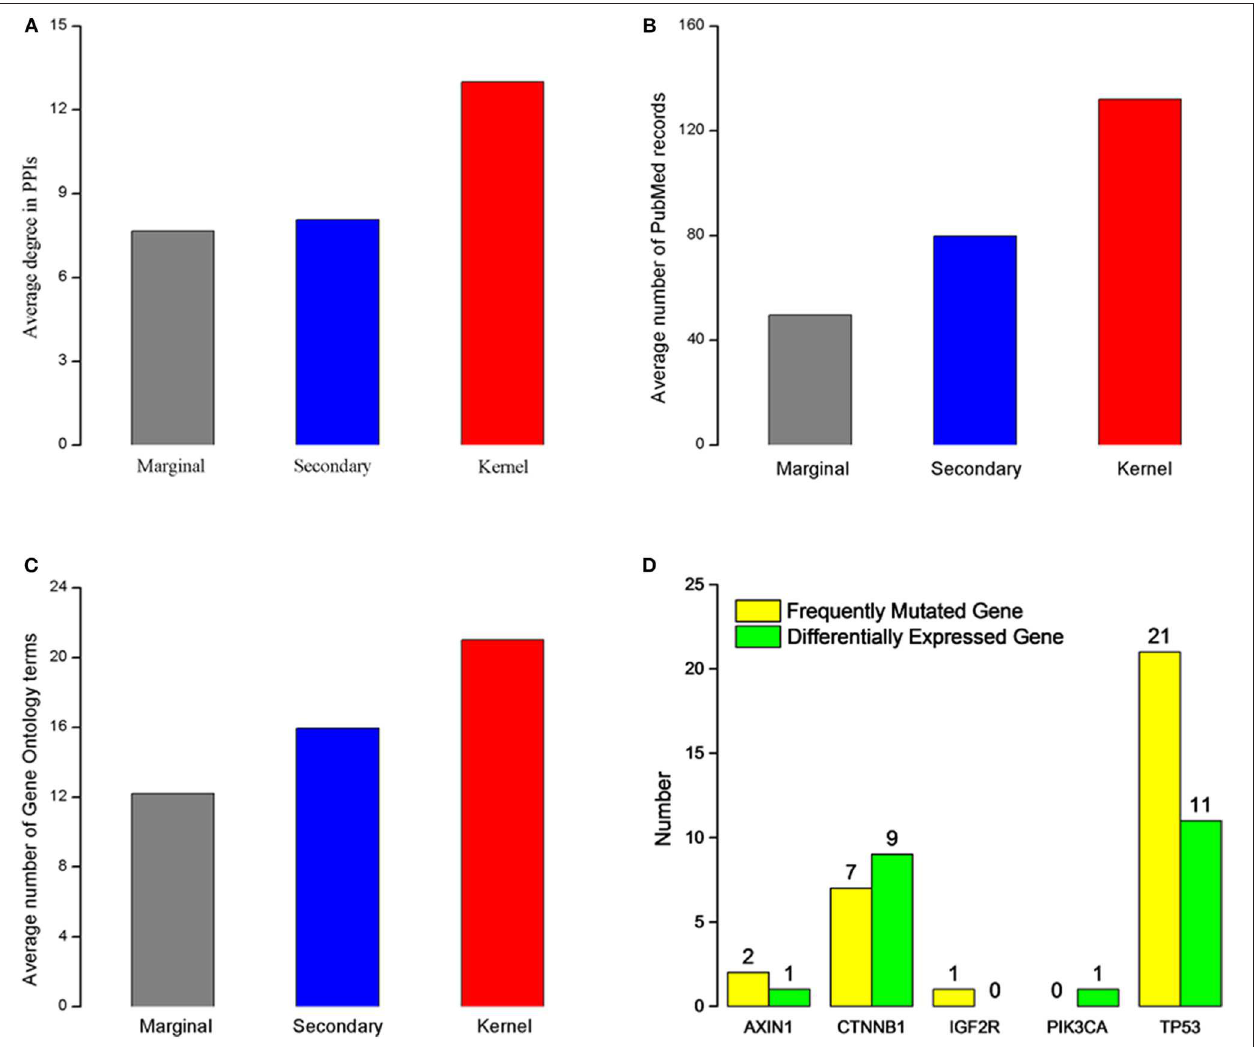
FIGURE 1 | Characteristics of the three gene types. (A) Average degree for three different gene types. (B) Average PubMed records associated for each gene type. (C) Gene Ontology terms annotated for each gene type. (A–C) The red rectangle represents kernel genes, the blue rectangle represents secondary genes, the gray rectangle represents marginal genes. (D) Type distribution of five kernel genes’ direct neighbor genes. Green rectangle represents differentially expressed genes in HCC, and yellow rectangle represents frequently mutated genes in patients with HCC.